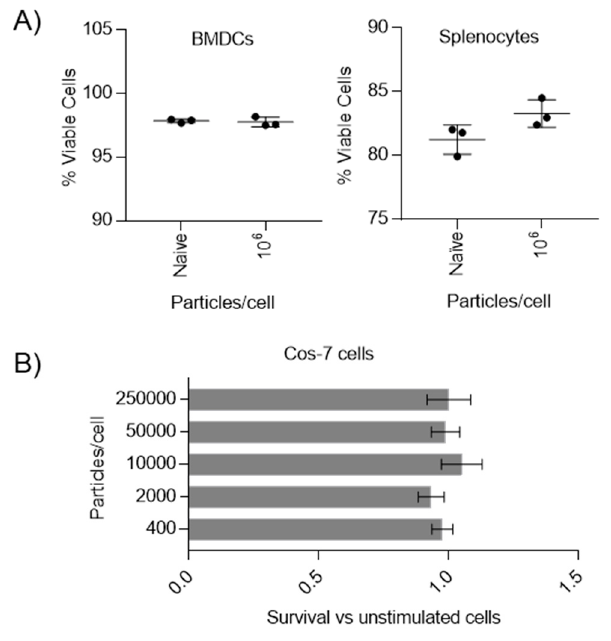
Figure 2. Assessment of pIONP toxicity in various cell types at different concentrations and time points. Nanoparticle toxicity in cultured cells and cell lines. Cell viability was assessed after 4–24 h of incubation using Zombie Aqua and flow cytometry. Data are plotted as mean +/- SD with individual replicates ( n = 3). ( A ) pIONP toxicity in bone marrow dendritic cells (BMDCs) and splenocytes after 24 and 12 h, respectively. ( B ) pIONP toxicity at a range of concentrations in Cos-7 cells measured by MTT assay and reported as survival relative to cells which were not stimulated with pIONPs.